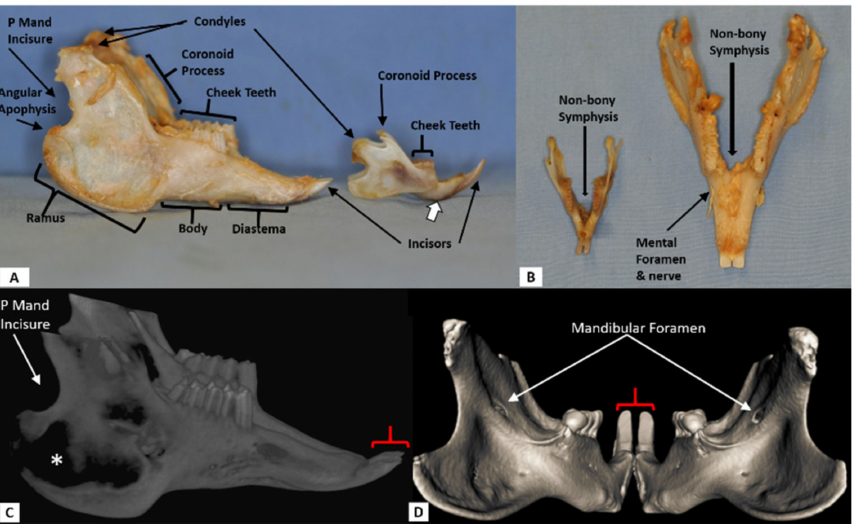
Figure 1. Non-defected adult male rabbit and rat mandible specimen. ( A ): Lateral view of the rabbit (left) and rat (right) compared side by side. ( B ): Dorsal (cranial) view (rabbit on right). Some of the features, which are characteristic of both animals, are only labeled on the rabbit mandible. The incisors are separated from the cheek teeth by a bony diastema that houses no teeth as canines are absent. The mandible body houses the cheek teeth (molars) and immediately posterior to the body is the ramus. Note that the reserve crown of the rat incisor, which can be discerned by the shape of the diastema (open white arrow in ( A )), extends into the body under the cheek teeth. In contrast, the rabbit incisor reserve crown does not extend beyond the diastema. ( C ): 3D CT reconstruction of the rabbit mandible, lateral view. Note the incisor symmetry (red bracket). Volume averaging of the thin ramus bone results in the artifactual appearance of no bone (*). Also note that the condyles are partly cut out of the image. ( D ): CT reconstruction of the rat mandible, posterior (caudal) view showing the lingual surface of the hemi-mandibles and incisor symmetry (bracket). The mandibular foramen is noted which transmits the inferior alveolar neurovascular bundle. Note that the coronoid processes are cut out of the image. P Mand Incisure = posterior mandibular incisure (notch in between the condyle and angular